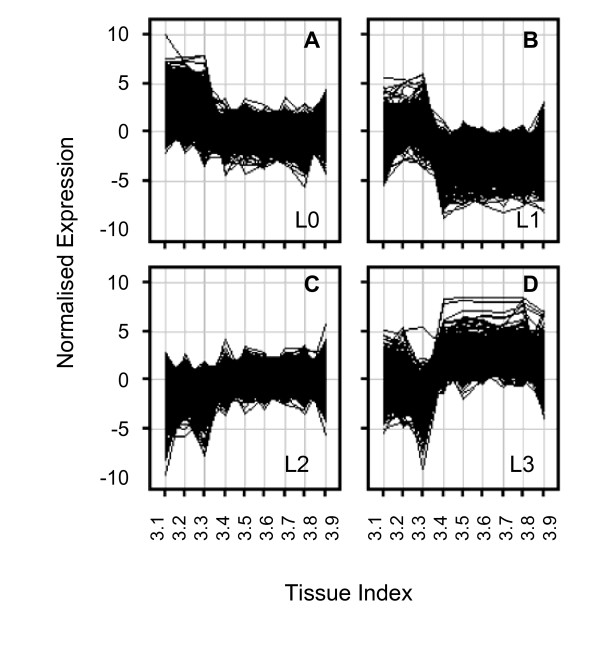
Changes in gene expression during leaf development. Genes showing differential expression between young and mature leaf samples were identified (see text for details). These genes were clustered by K-means into 4 groups L0 (A), L1 (B), L2 (C) and L3 (D). Expression data are normalised to the median across all 19 tissues in TobEA (y-axis) and plotted against the leaf development samples (TTI 3.1 - 3.9; x-axis).